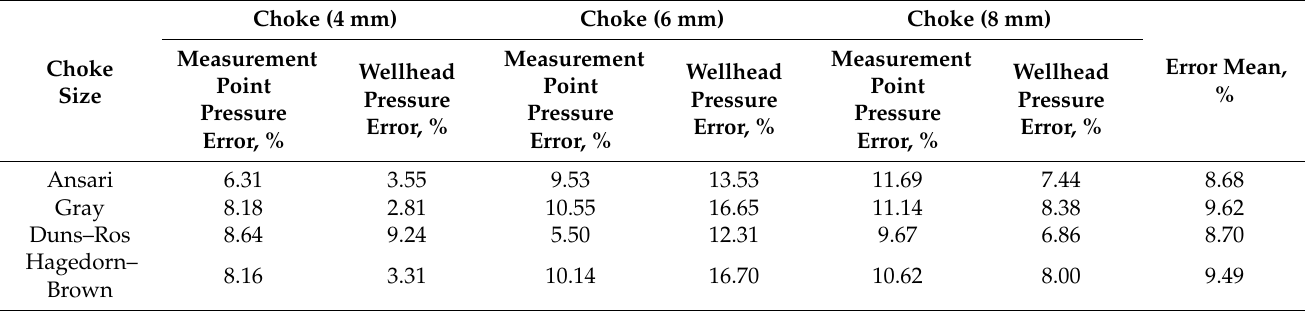
Table 3. Calculation error of six pressure measurement points of four multiphase flow calculation